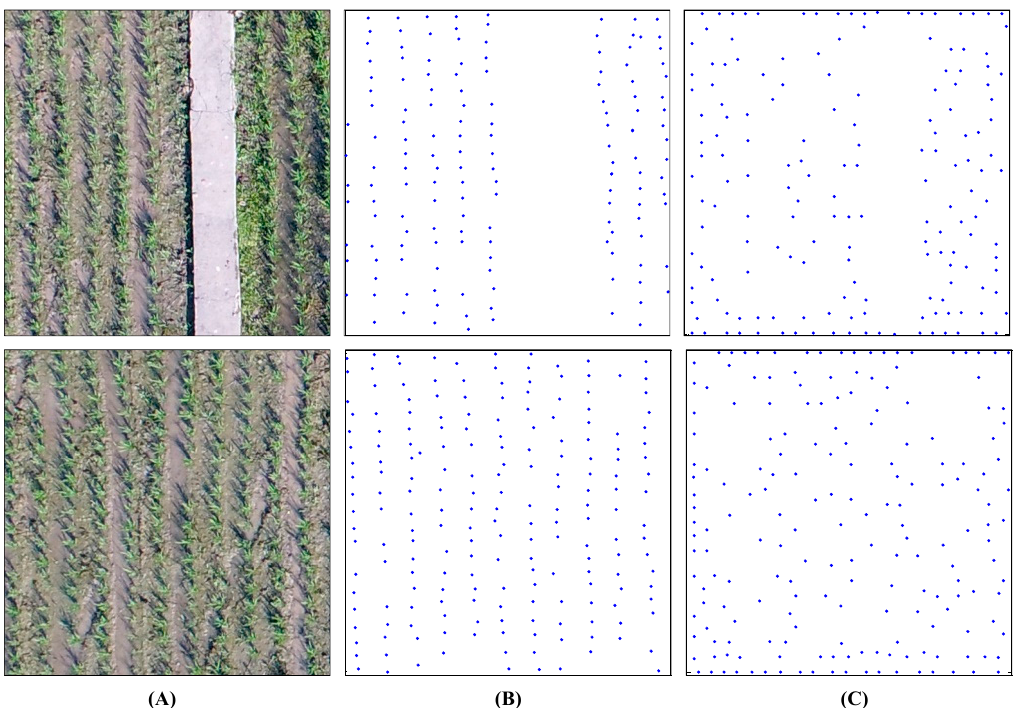
Figure 14. Examples of predicted rice seedling distribution maps extracted from the final density map: ( A ) cropped UAV images where rice seedlings are unevenly (upper image) and evenly (lower image) distributed; ( B ) ground truth rice seedling distribution map where the points represent rice seedlings; ( C ) predicted rice seedling distribution map extracted from the final density map using the k-NN algorithm.